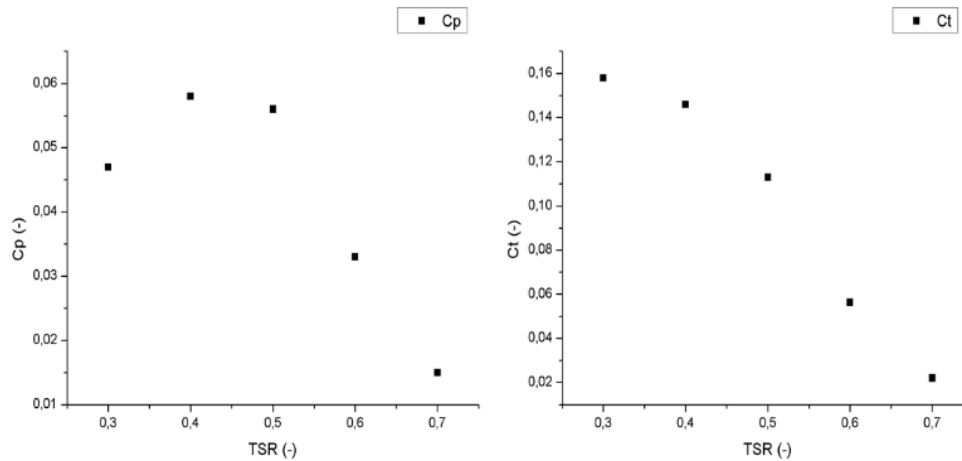
Figure 11: Graph of correlation a) C p with TSR and b) C t with TSR on Rotor Two-Stage 0 ∘